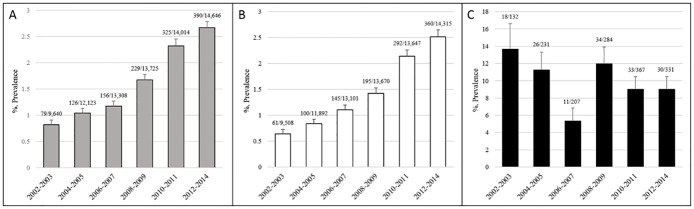
Trends in prevalence of candida esophagitis, 2002–2014.(A) All subjects, (B) non-HIV-infected patients, (C) HIV-infected patients. Values on bars are number of subjects testing positive/total number tested. Error bars show 95% confidential intervals.